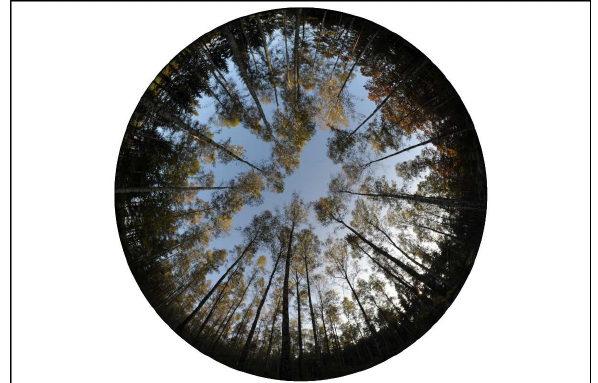
Figure 2: Hemispheric forest crown